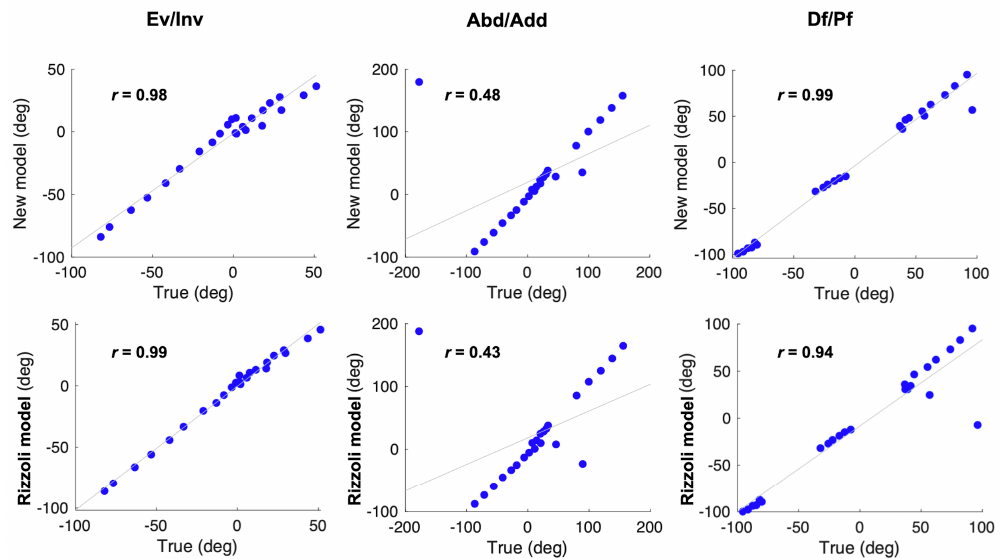
Figure 5. Univariate analysis using Pearson’s correlation analysis. Left to right, the Met_Hal angle in the frontal, transverse, and sagittal planes are shown. Correlations were assessed between the true values and the calculated values according to the two models; our new model (first row) and the Rizzoli model (second